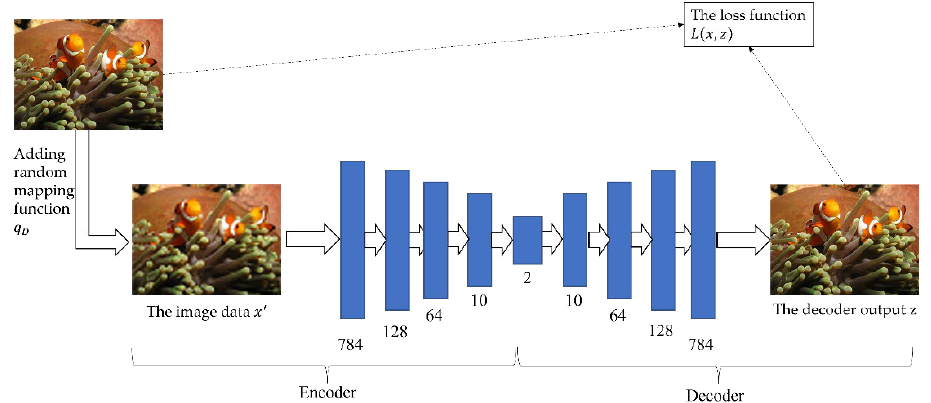
Figure 4. The structure of the denoising autoencoder. The input image data x is corrupted to x (cid:48) . The autoencoder then maps it to the output data y and attempts to reconstruct x ( z